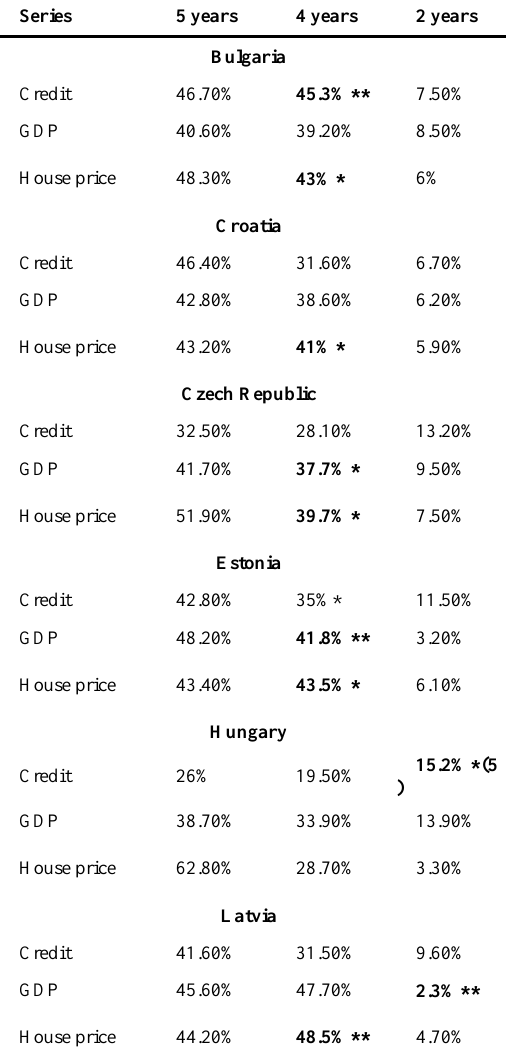
Table 1. Univariate Singular Spectrum Analysis